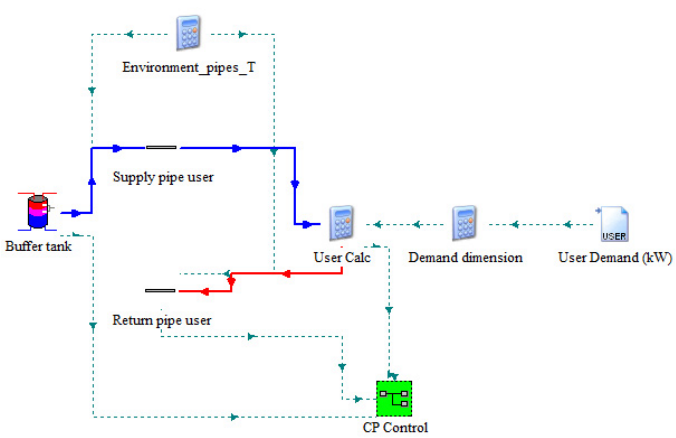
Figure 4. User loop macro [30].